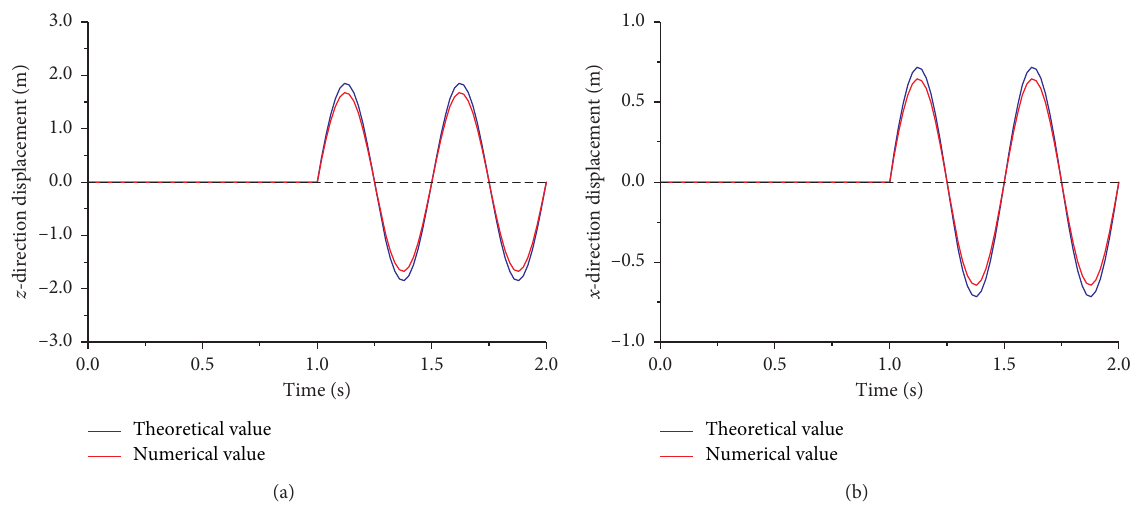
Figure 8: Displacement time history of point A under 20 ° incident angle: (a) z -direction and (b) x -direction.